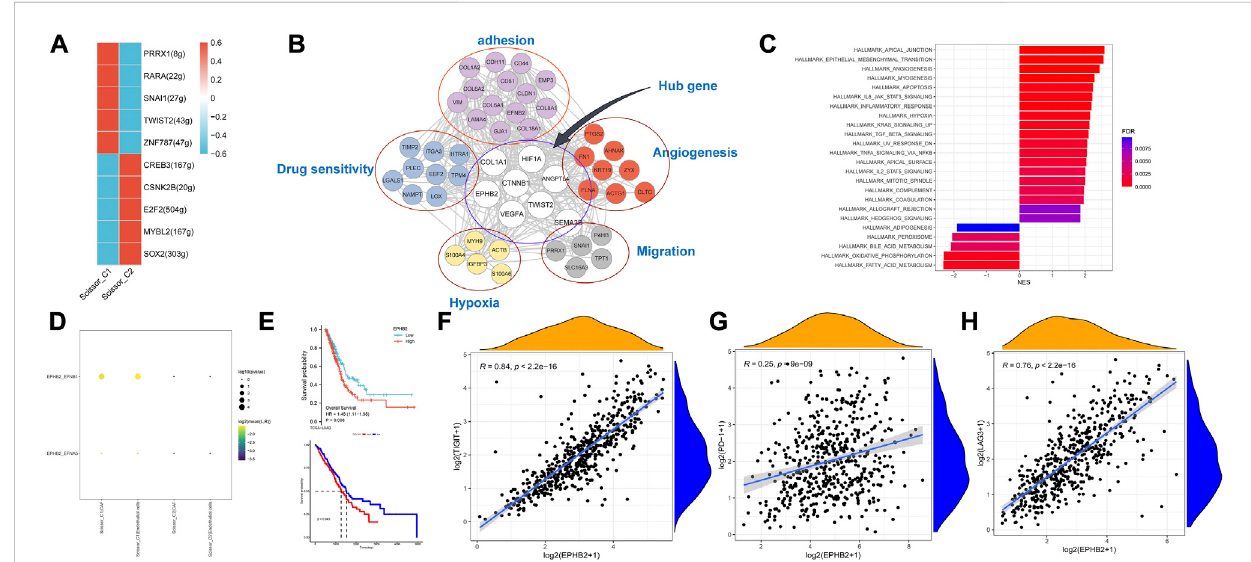
FIGURE 11 (A) Transcription factors signi fi cantly differentially activated by Scissor_C1 and Scissor_C2. (B) Scissor_C1-speci fi c gene regulatory network. (C) GSEA analysis of high and low expression of COL1A1. (D) Scissor_C1 is speci fi cally activated by ligand pairs with EPHB2-EFNB1 in endothelial cells. (E) PrognosticcomparisonofCOL1A1andEPHB2. (F – H) EPHB2issigni fi